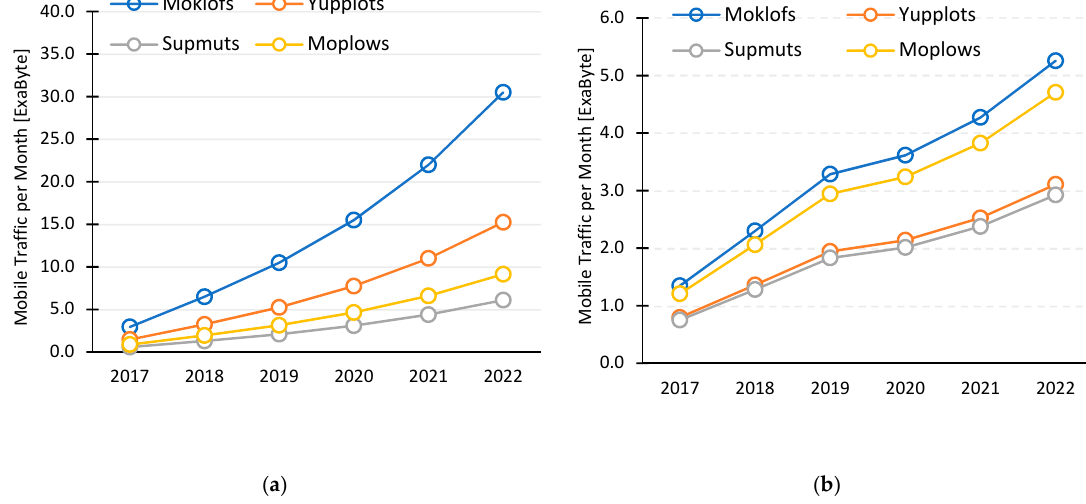
Figure 10. Mobile traffic per month for each of the original four clusters: ( a ) video and ( b ) non- video.